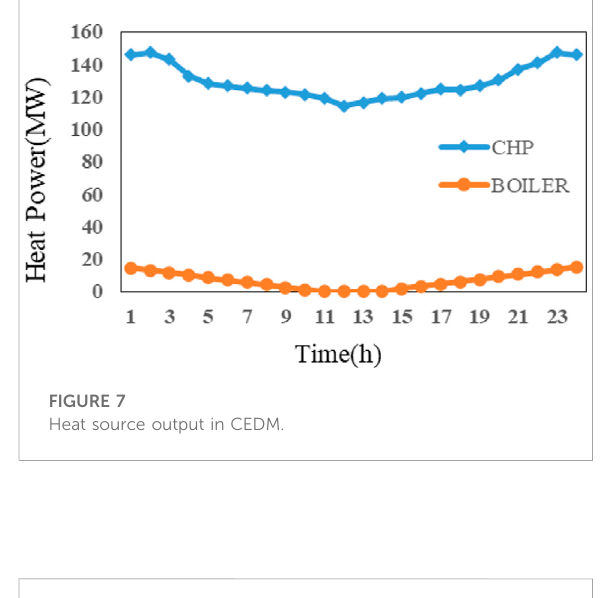
TABLE 2 Cost of two modes and